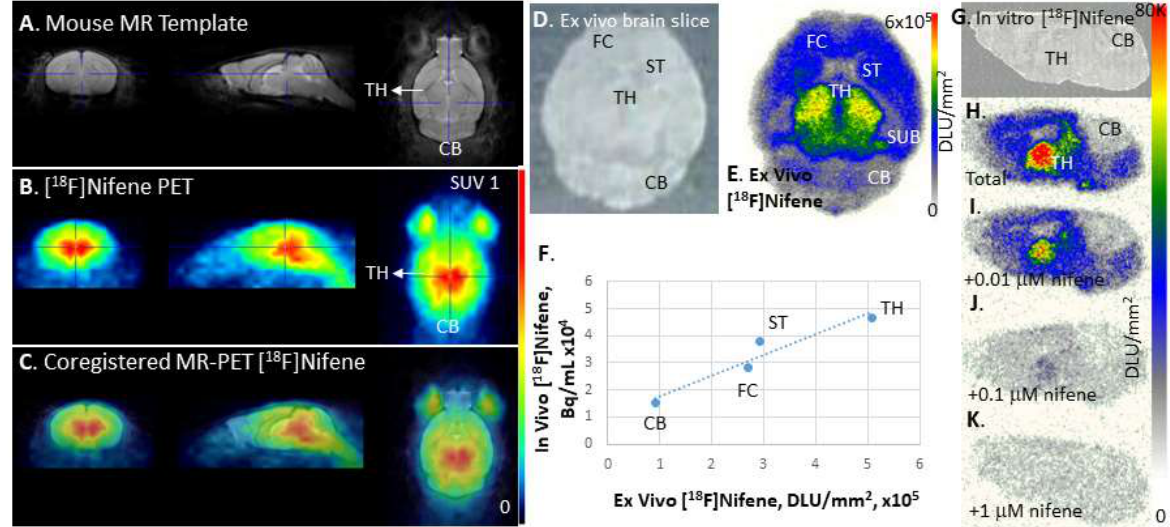
Figure 5. PET-MR of [ 18 F]nifene: ( A ) Mouse brain MR template showing coronal, sagittal and transaxial slices, with cross hairs placed on the thalamus; ( B ) [ 18 F]nifene PET coronal, sagittal, and transaxial slices, 30 min post IP injection (5.50 MBq in 100 mL saline) in wild-type mouse (C57BL/6, male 28 g); ( C ) [ 18 F]nifene PET co-registered with mouse MR template ( A , B ); ( D ) mouse brain slice ex vivo 30 µm thick; ( E ) ex vivo autoradiograph of [ 18 F]nifene of mouse slice ( D ), after PET experiment in ( B ), showing regions-of-interest for analysis; ( F ) comparison of [ 18 F]nifene in vivo PET and [ 18 F]nifene ex vivo brain slice autoradiograph ( B vs. E ) using four brain regions; ( G – K ) in vitro [ 18 F]nifene binding in 10 mm sagittal mice brain ( G ) slices showing [ 18 F]nifene binding ( H ; 100%) and effect of 0.01 mM ( I ; 72%), 0.1 mM ( J ; 15%), and 1 mM ( K ; 6%) unlabeled Nifene.